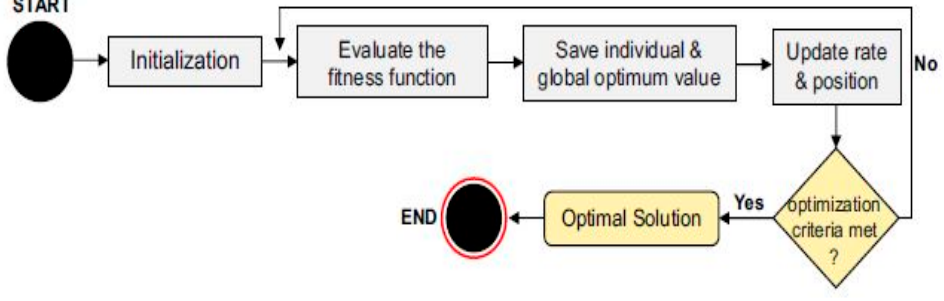
Table 3. Comparison between IGA and EIGA.